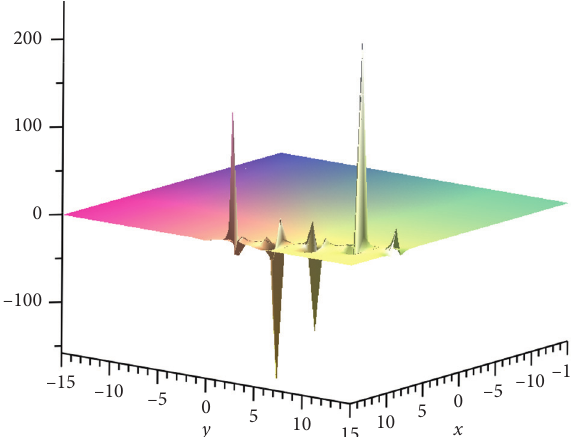
Figure 5: The breather solution u of equation (1) with the parameter selections m � 2 , p � 1 , k � 2 , δ